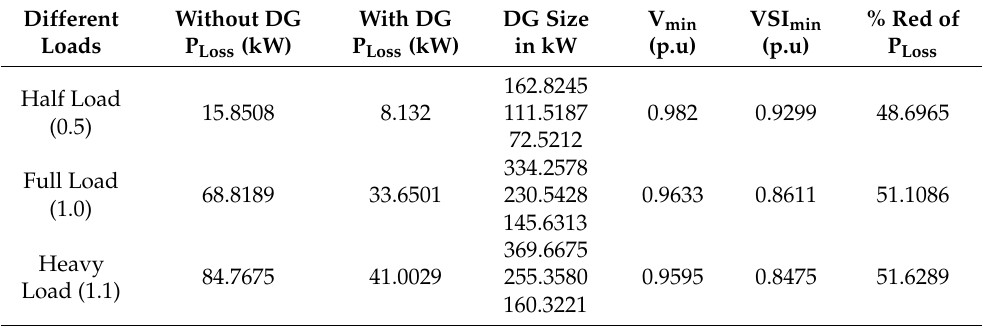
Table 3. Suitable capacity of DGs at different load levels.